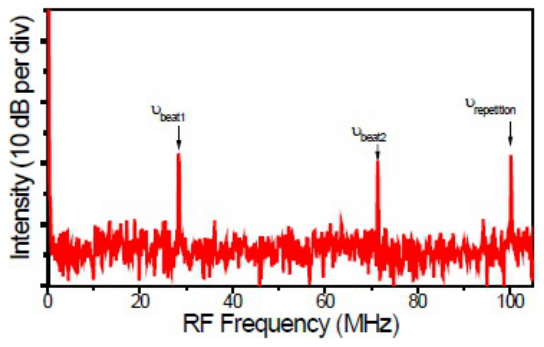
Fig. 23. Narrow linewidth beat the temporal coherence of he super- continuum shown in Fig. 22 notes illustrating the temporal coher- ence of the supercontinuum. Adapted from reference